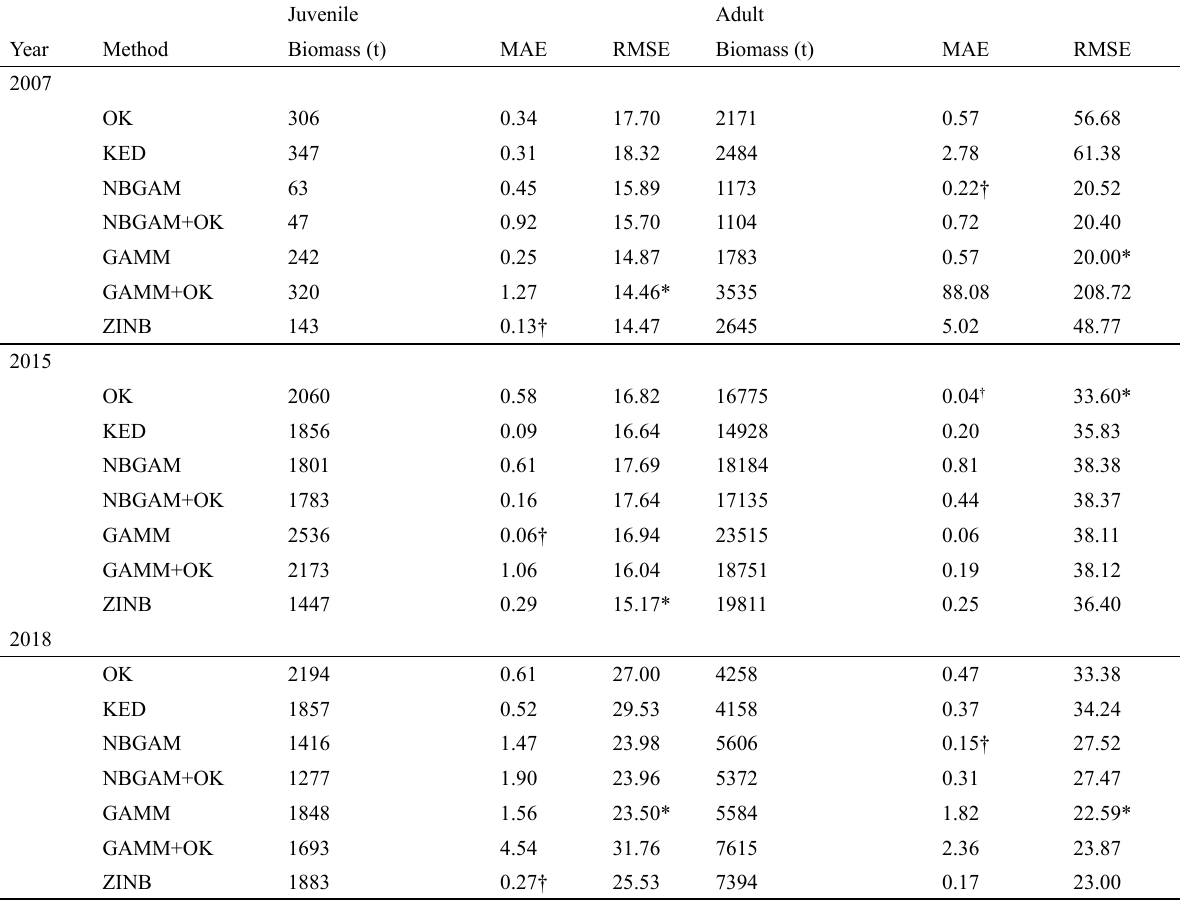
Table 2. – Juvenile and adult queen conch biomass estimation from alternative spatial interpolation models a and corresponding ten-fold cross- validation diagnostics b . Bold: estimated biomass selected for adults and